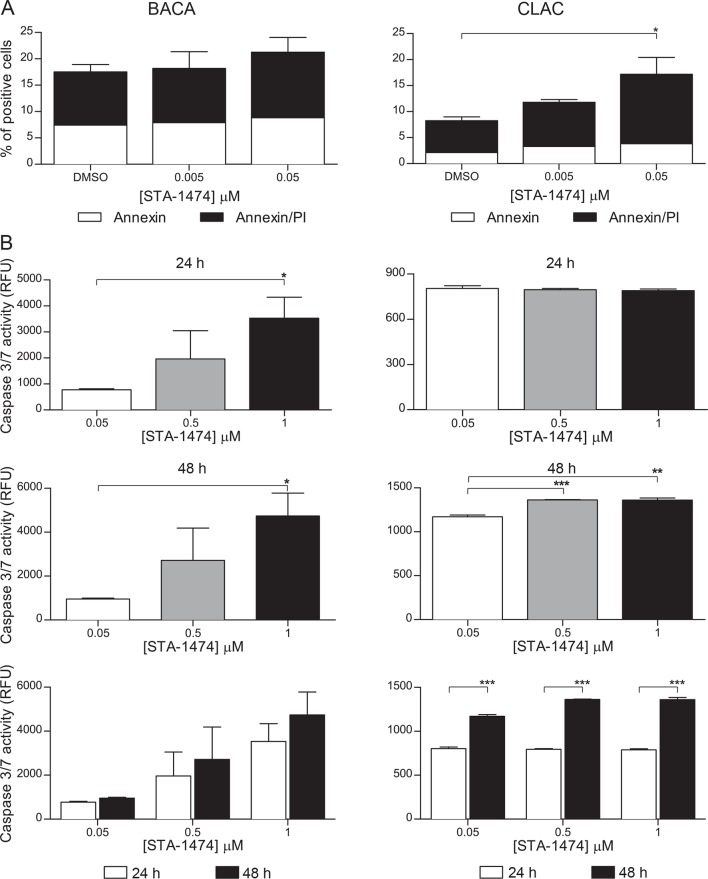
Evaluation of apoptosis in canine lung cancer cell lines treated with STA-1474.Apoptosis was assessed by annexin V/PI staining flow cytometry and detection of caspase 3/7 enzymatic activity. (A) Cells were treated with dimethyl sulfoxyide (DMSO, control) or 0.005–1 μM of STA-1474 for 24 h. Staining with annexin V and the vital dye, propidium iodide (PI), were used to evaluate early and late apoptosis. Cells that are considered viable are both annexin V and PI negative, while cells that are in early apoptosis are annexin V positive and PI negative, and cells that are in late apoptosis or already dead are both annexin V and PI positive. (B) Both cell lines were treated as above and evaluated for executioner caspase-mediated apoptosis. Activated caspases 3 and 7 were assessed 24 and 48 h after treatment. Experiments were performed in triplicate and repeated three times. Each graph shows mean ± SEM. *, p<0.05; **, p<0.01; ***, p<0.001.